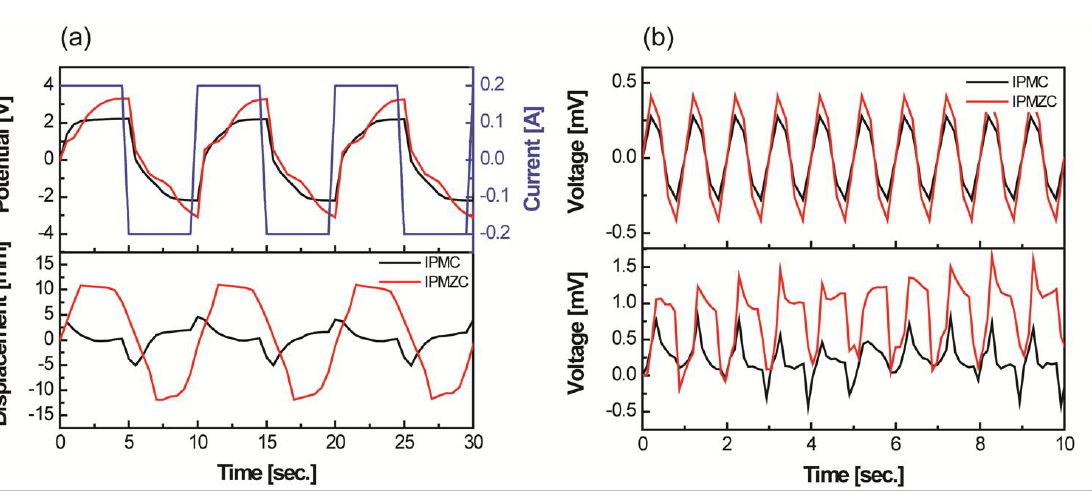
Figure 5. (a) Electro-mechanical property: the output potential (top) and corresponding displacement result (bottom) in applied current input (−200 to 200 mA) and (b) Mechano-electro property: simulated result (top) and experimental output voltage (bottom) on application of 12.7 mm sinusoidal displacement with the frequency of 1